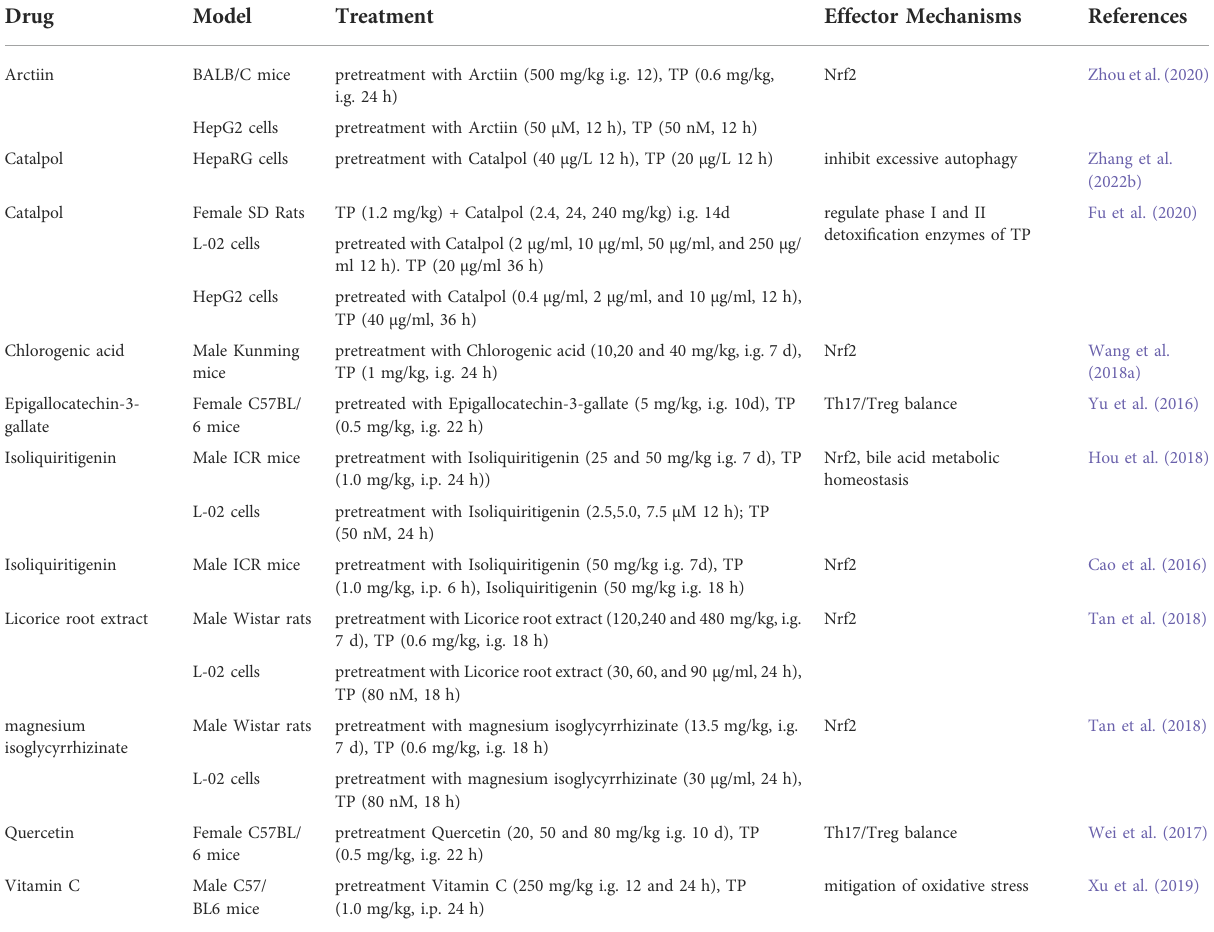
TABLE 1 Detoxi fi cation strategies for